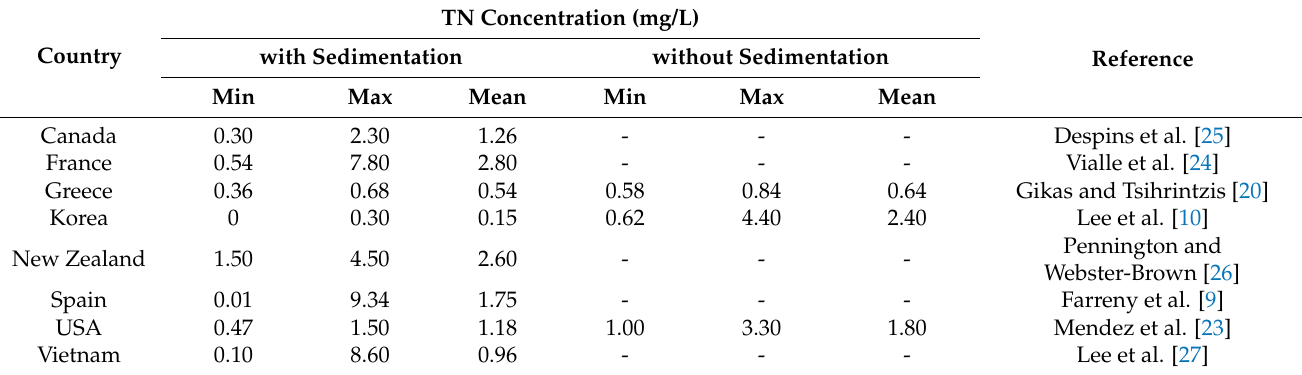
Table 3. Measurements on TN concentration.